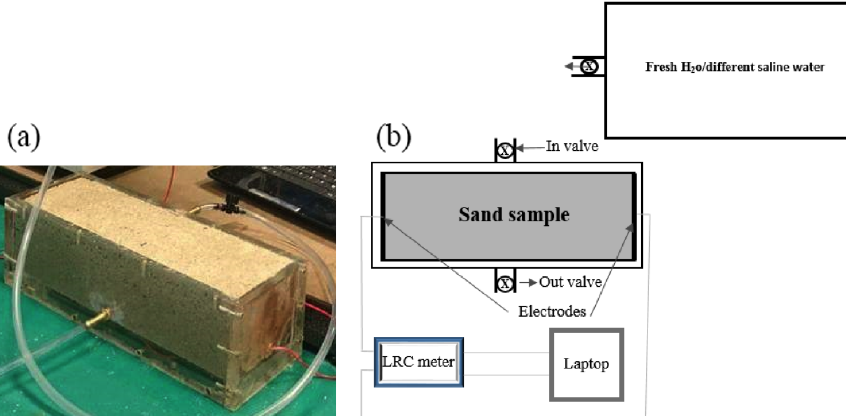
Figure 2. Photo (a) and schematic drawing (b) of the experimental set-up for the static